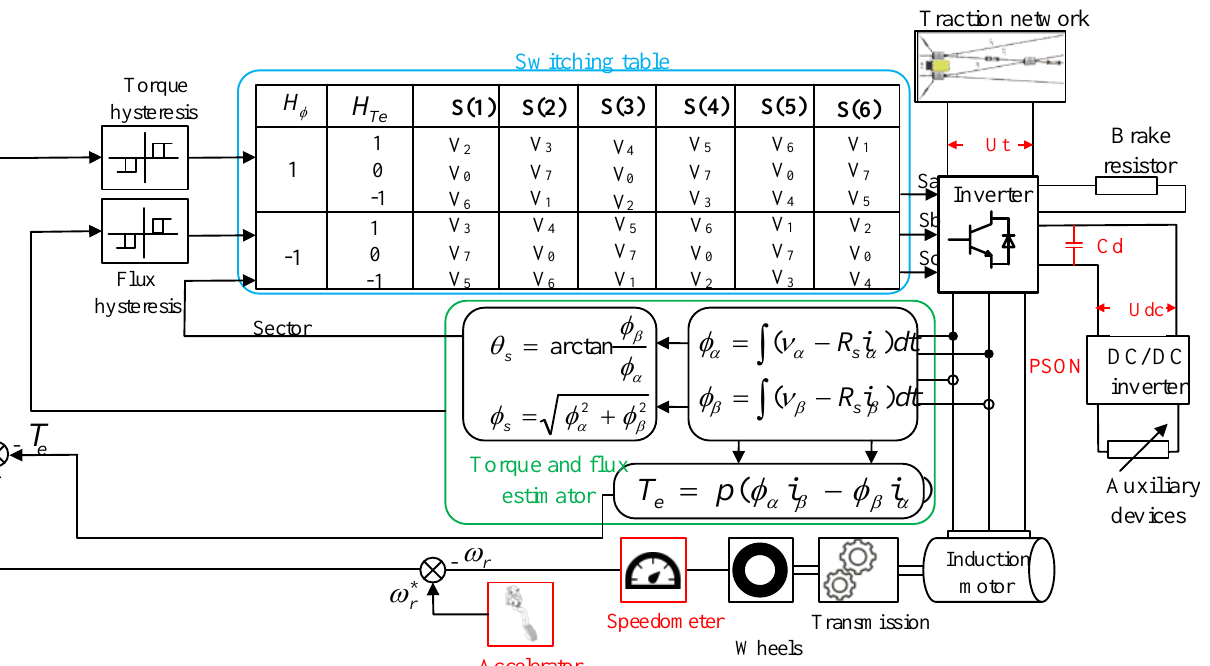
-- Figure 7. Circuit diagram of the trolleybus used in the simulation. Figure 7. Circuit diagram of the trolleybus used in the